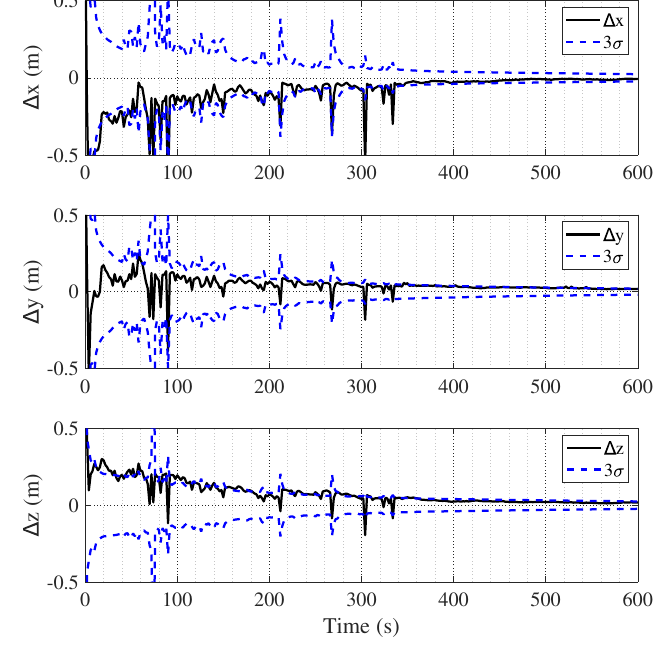
Figure 12. Position error.